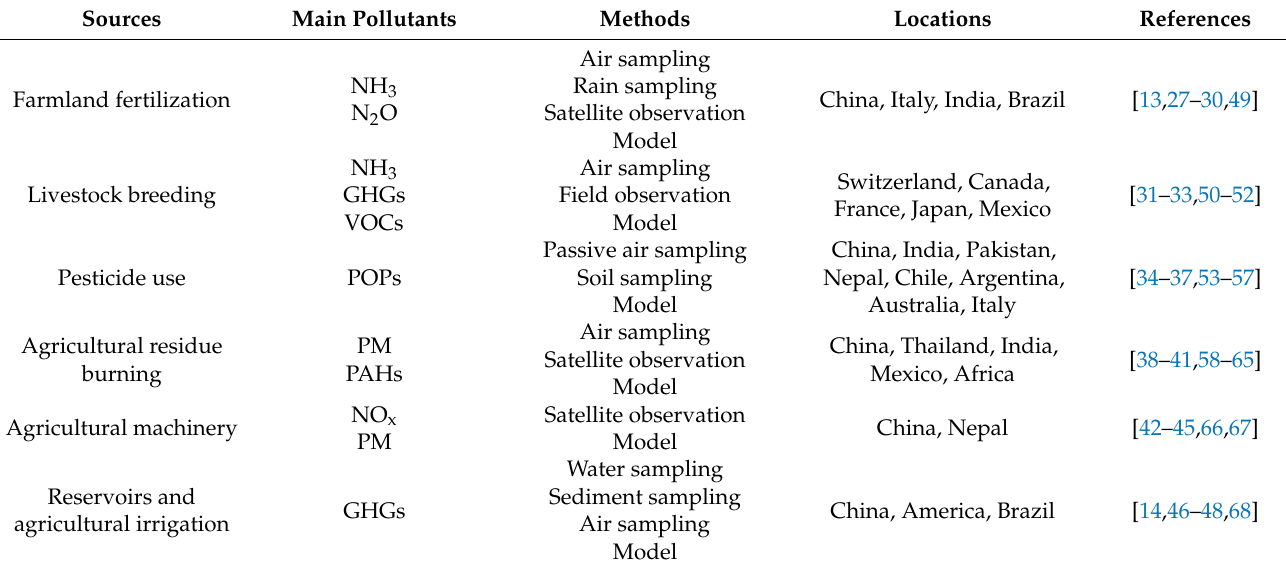
Table 1. Main pollutants, methods and locations of studies on agricultural air pollution in recent